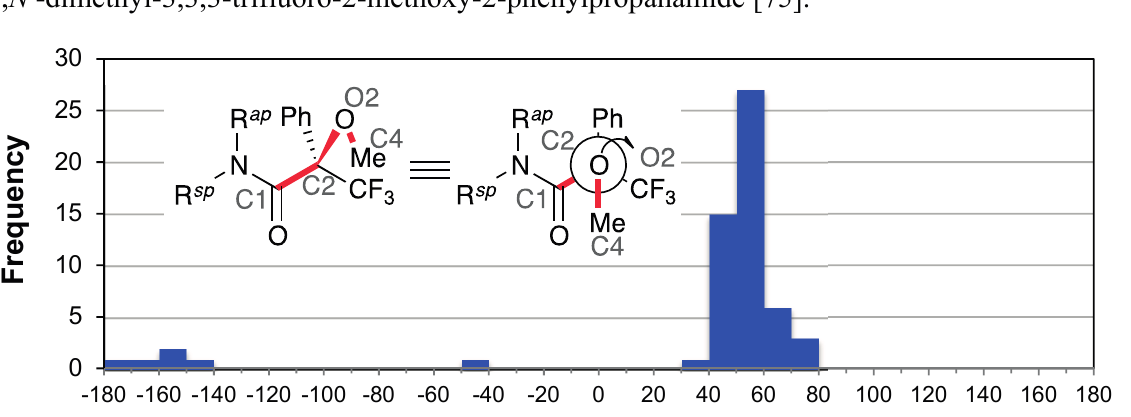
Figure 10. Histogram for dihedral angles between the methoxy and phenyl groups of all MTPA